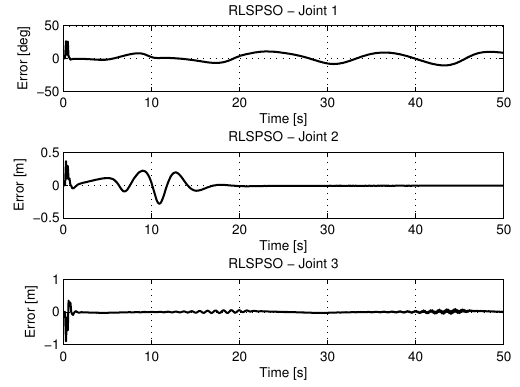
Figure 18. Error of Trajectories identifications with RLSPSO.